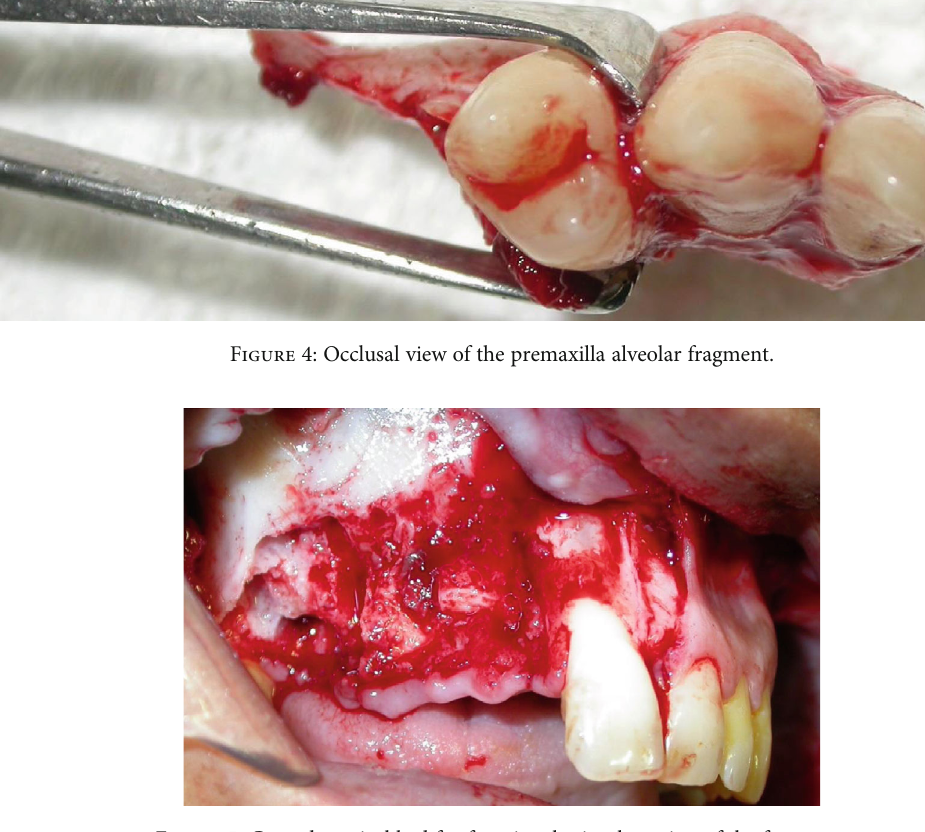
Figure 5: Curved surgical bed for functional reimplantation of the fragment.